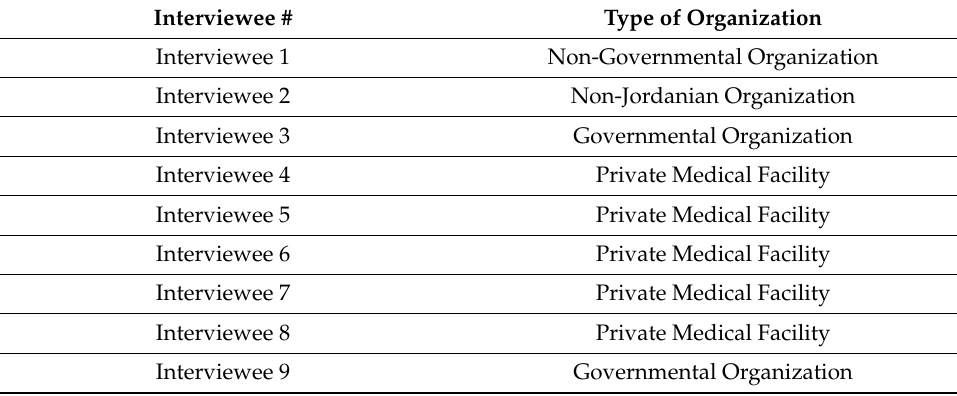
Table 1. Study’s